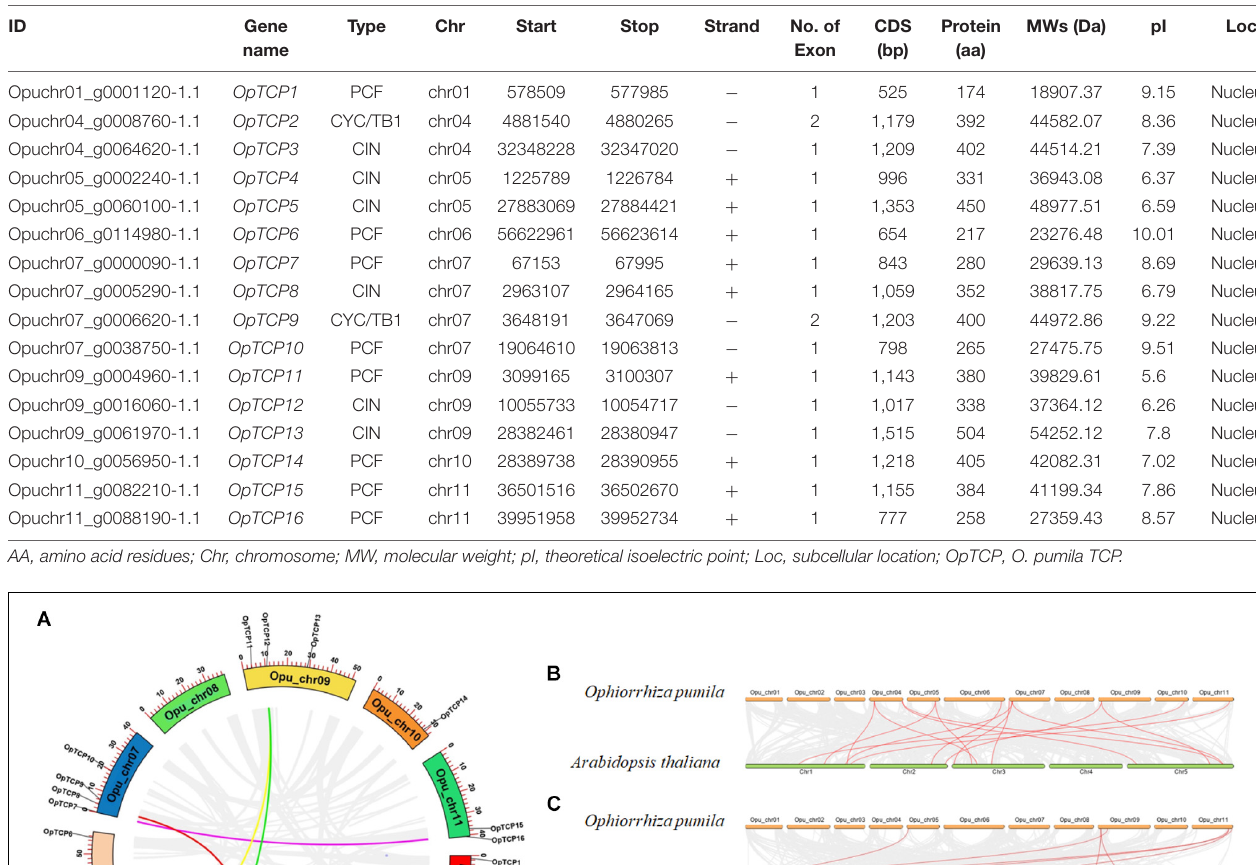
TABLE 1 | Detailed information for 16 OpTCP genes in the O. pumila genome.